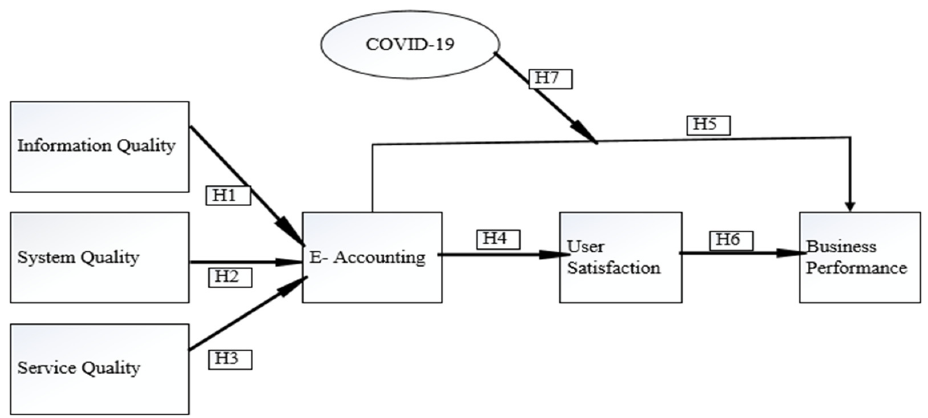
Figure 1. Research Framework.